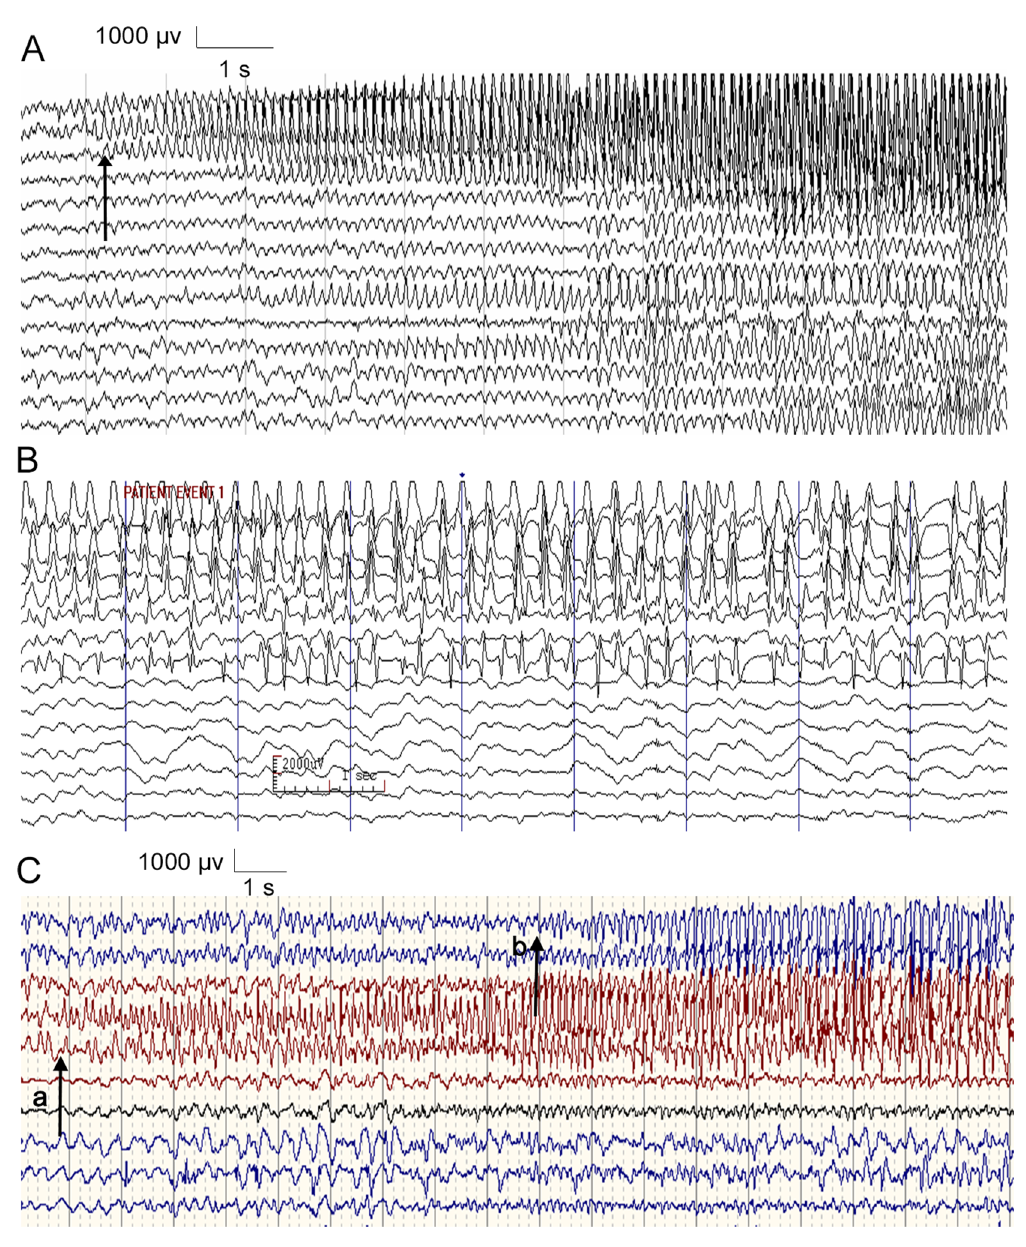
Figure 1. The characteristics of partial seizures on intracranial electrode EEG. (A) The localized original site (arrow); (B) The relatively high voltage of epileptiform discharge; (C) The relatively long propagation time. The spreading time of the discharge from point ‘‘a’’ to point ‘‘b’’ (arrows) was about 9 seconds.